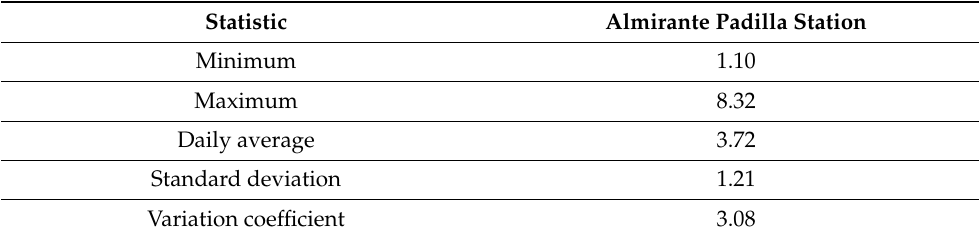
Table 1. Statistics of daily wind speeds by station